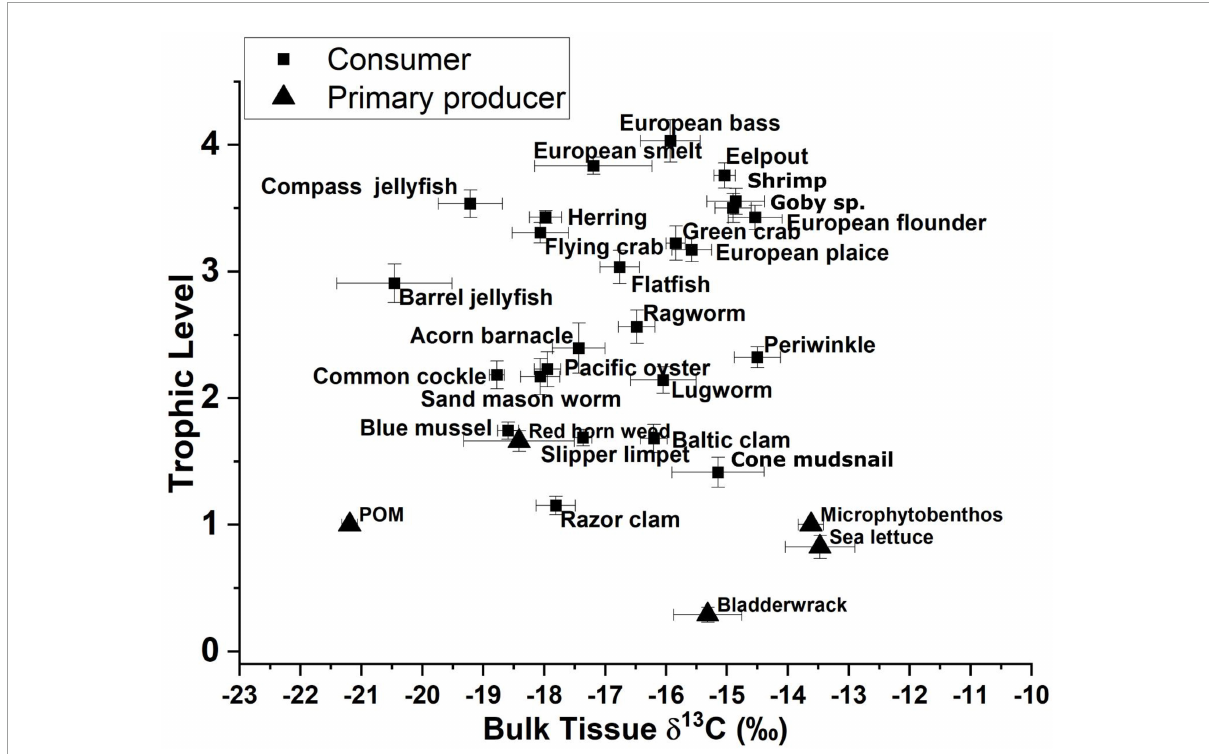
FIGURE4 Trophic-level estimates from amino acid δ 15 N values for glutamic acid and phenylalanine vs. bulk δ 13 C values for both consumers and primary